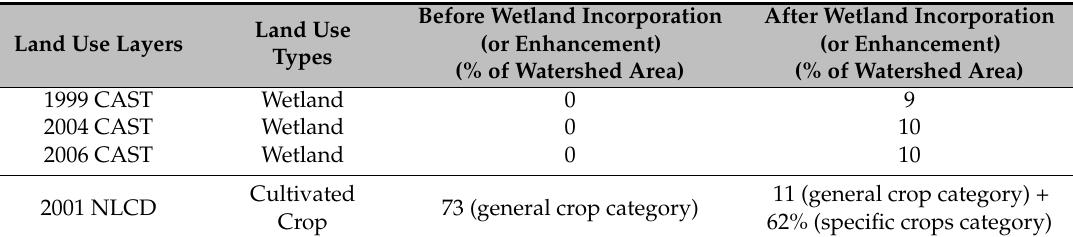
Table 3. Transformation of wetland in CAST and cultivated crop in NLCD land-use